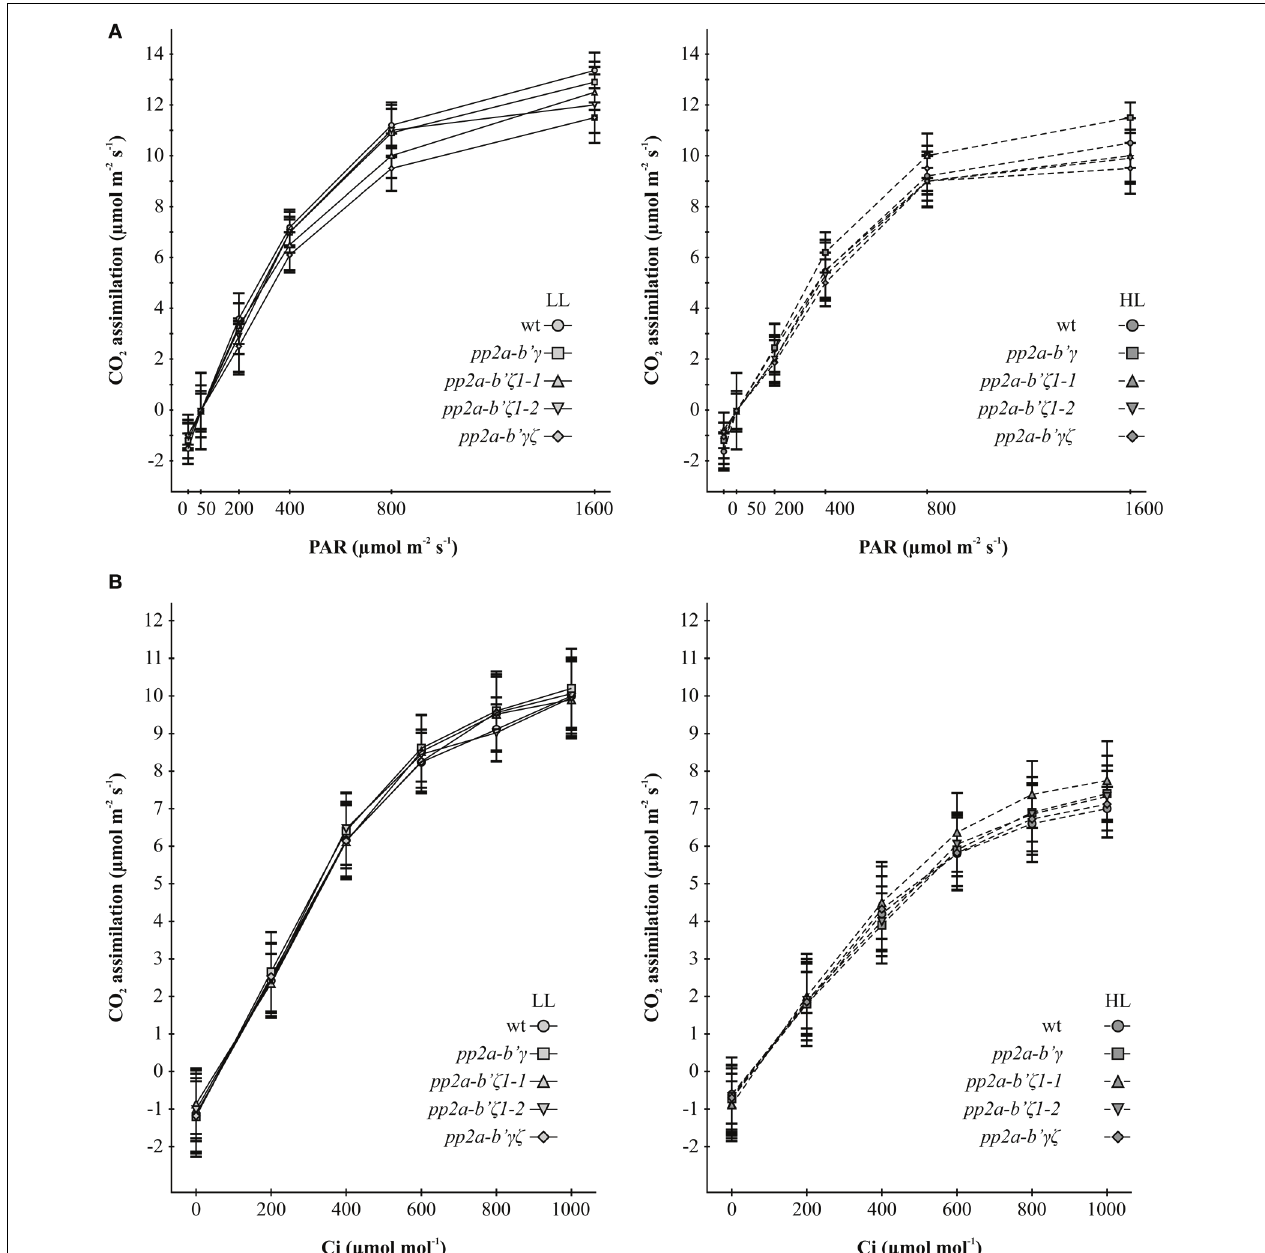
FIGURE 5 | A comparison of the light saturation curves for photosynthesis (A) and the CO 2 response curves for photosynthesis (B) in the pp2a-b’ γ , pp2a-b’ ζ 1-1 , pp2a-b’ ζ 1-2 , and the pp2a -b ’ γζ double mutant grown under either low light (LL) or high light (HL) conditions. The light saturation curves for photosynthesis (A) and the